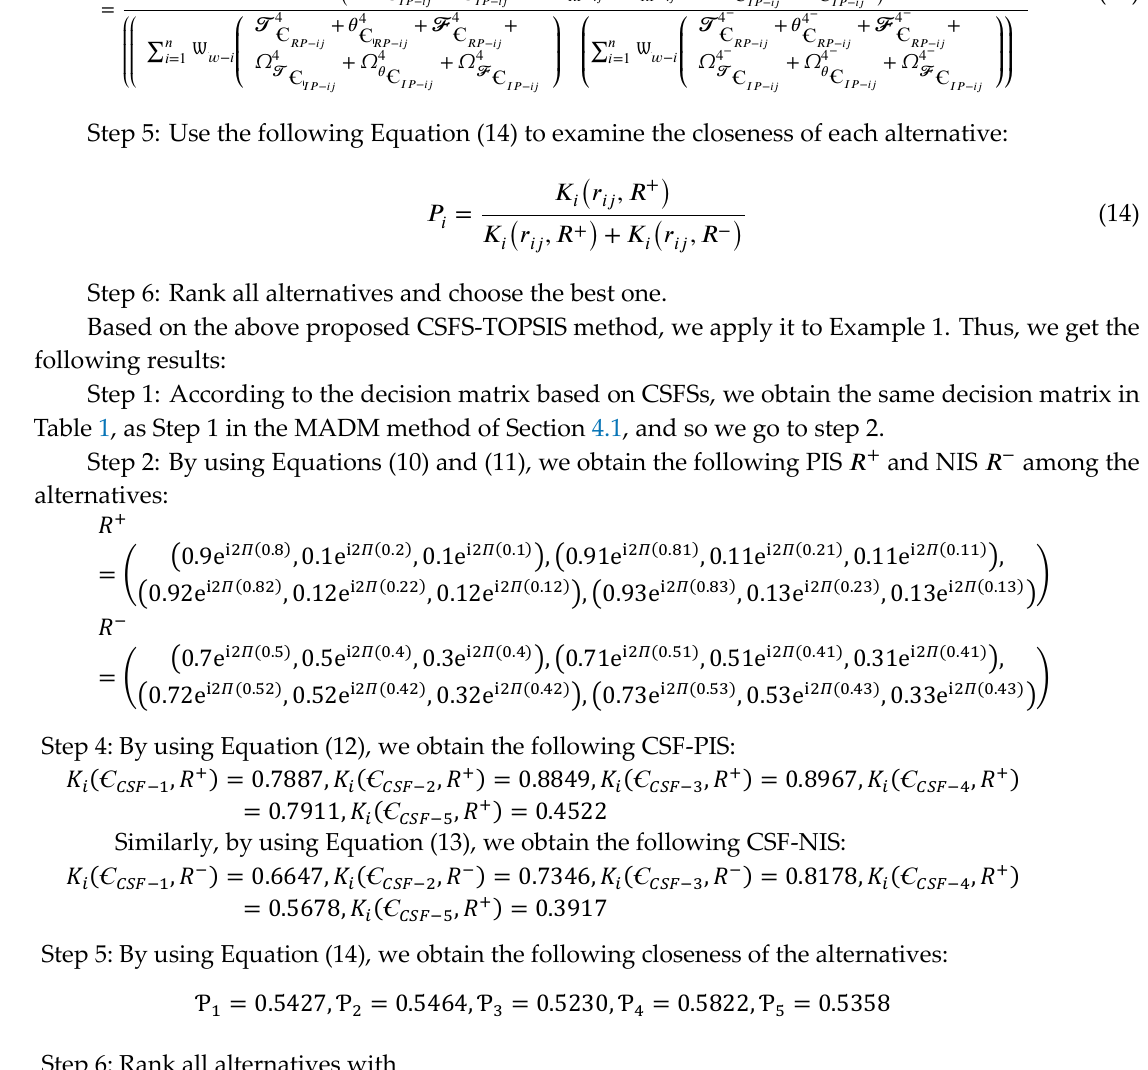
Table 3 . Comparative analysis for the information in Table 1